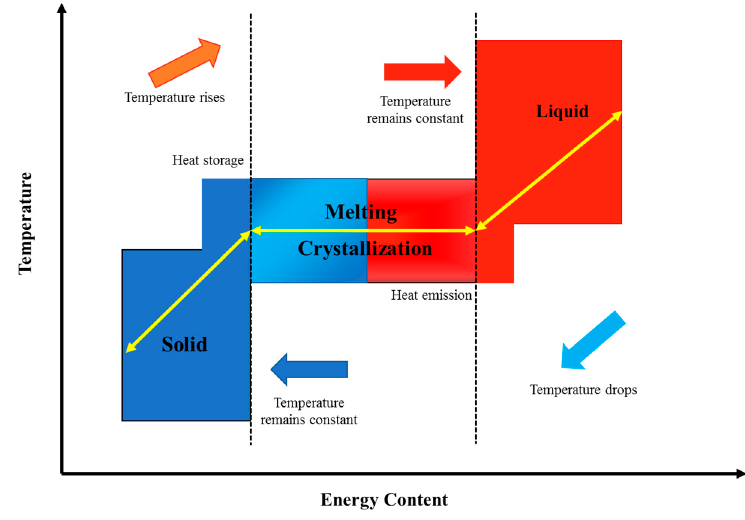
Figure 3. Phase changing phenomenon.